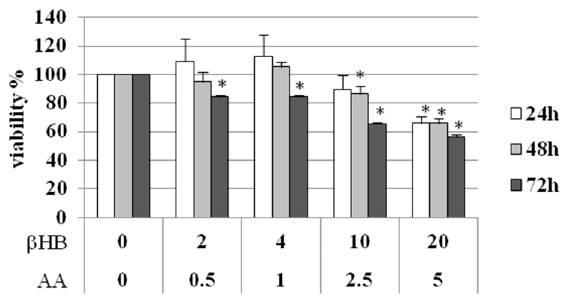
Figure 1. Viability of HMEC-1 treated with KB ( β HB 2–20 mM and AA 0.5–5 mM). Data are expressed as mean ± SD. * p < 0.05 compared with control ( β HB = 0 and AA = 0).